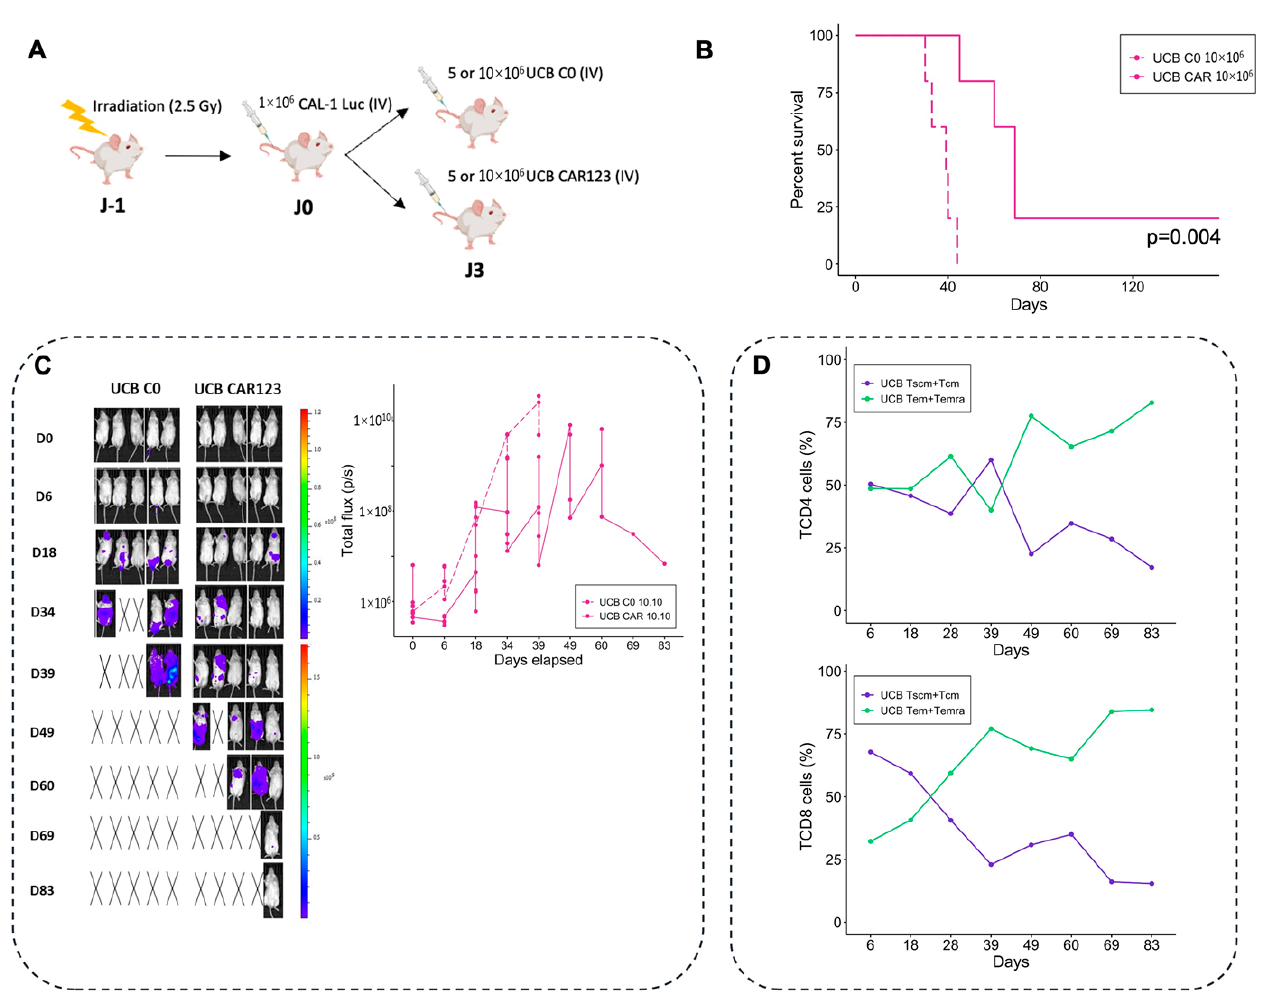
Figure 4. In vivo functionality of UCB CAR-T. ( A ) The experimental protocols. ( B ) Overall survival of mice treated with fresh UCB CAR-T, and the control group (C0), over time ( n = 5 mice per group, dose: 10 × 10 6 T cells). ( C ) Bioluminescent intensity of the mice treated with UCB CAR-T and the control groups ( n = 5 mice per group). Black cross indicates dead mice. ( D ) Percentage of different T cell subsets (T SCM + T CM and T EM + T EMRA ) for UCB CAR-T (TCD4 and TCD8), for each group, over time. UCB: Umbilical Cord Blood.